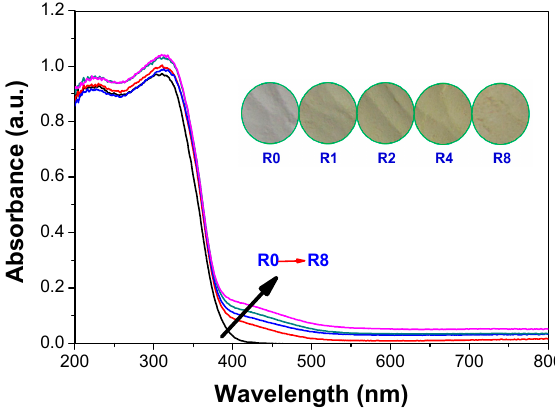
Figure 4. Diffused reflectance spectroscopy and the corresponding optical digital images (inset) of the prepared photocatalysts.